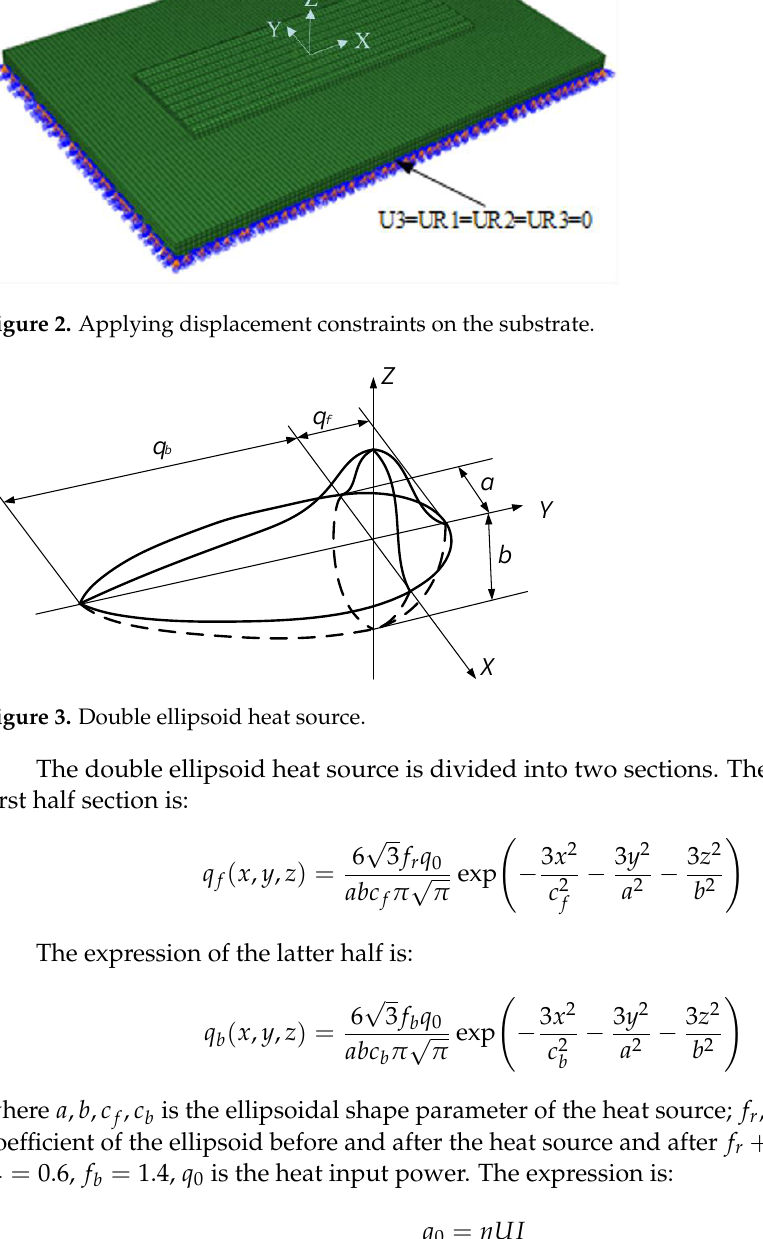
Figure 3. Double ellipsoid heat source.